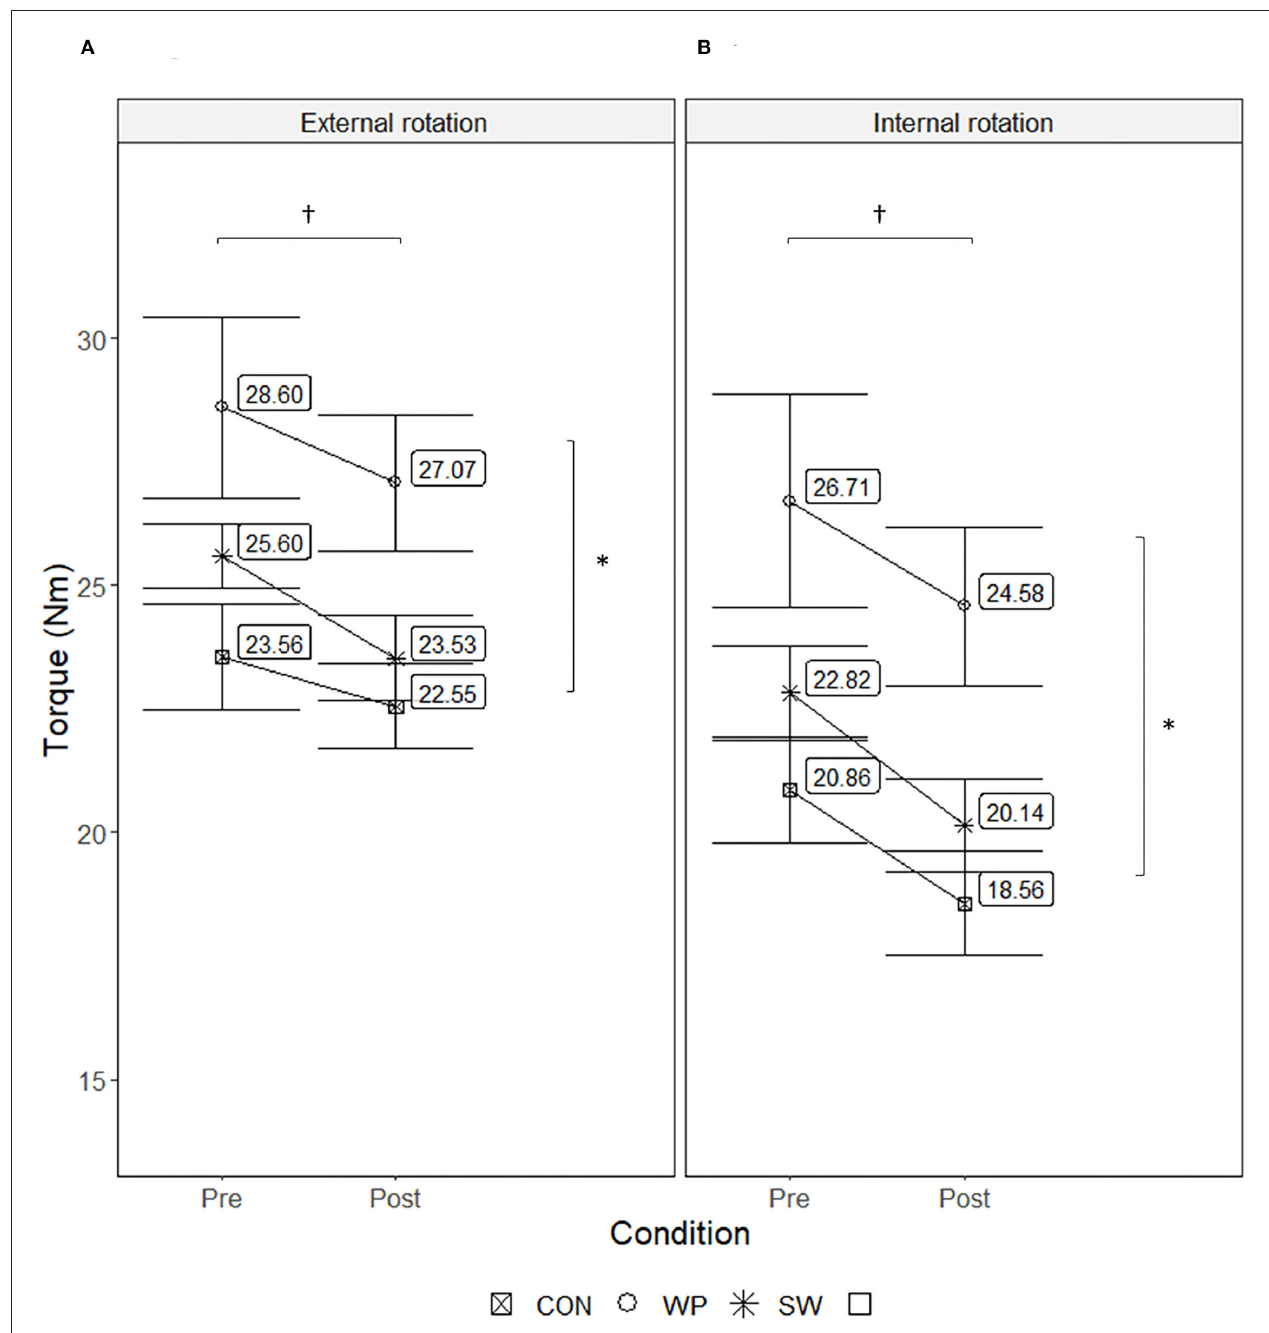
FIGURE 2 | Maximal concentric external (A) and internal (B) shoulder rotation torque produced by water polo athletes (WP), swimmers (SW), and a control group (CON) before and after a concentric shoulder internal rotation fatigue protocol. Values displayed are estimated marginal means ± SE. † Indicates a significant main effect of the condition, with decreased torque values after the fatigue protocol ( p < 0.05). *Indicates significant group difference, with WP producing significantly greater torque than CON ( p < 0.05).